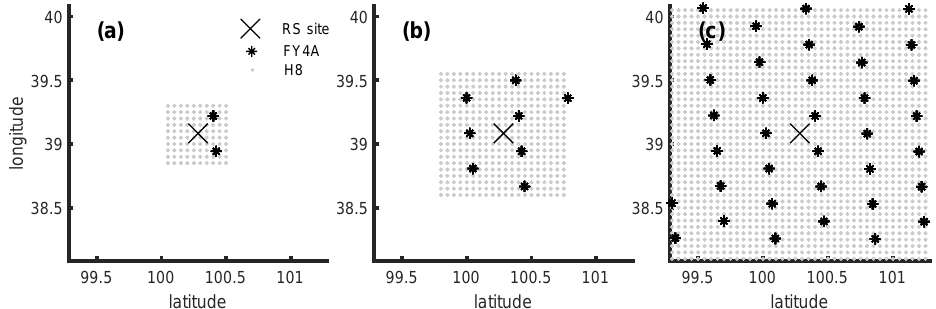
Figure 1. Illustration of the data collocation. The cross points are radiosonde sites, black stars are FY4A observation pixels, and grey dots represent Himawari-8 pixels. ( a ) FY4A and Himawari-8 pixels with distances from the radiosonde site smaller than 0.25 ◦ in latitude and longitude; ( b ): FY4A and Himawari-8 pixels with distances from the radiosonde site smaller than 0.50 ◦ in latitude and longitude; ( c ): FY4A and Himawari-8 pixels with distances from the radiosonde site smaller than 1.00 ◦ in latitude and longitude. All three sub-figures contain the pixels within one hour after balloon release. The scheme represented in panel ( b ) is used in the current